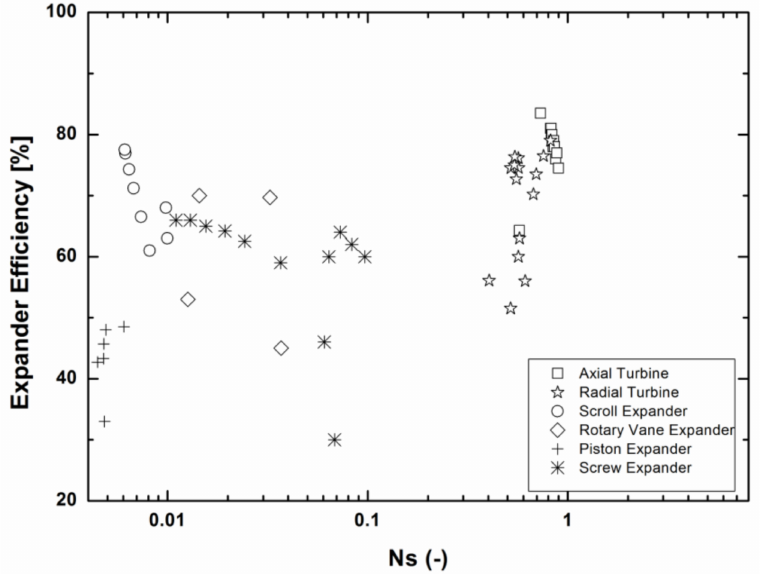
Figure 12. Expander efficiency vs. specific speed for different